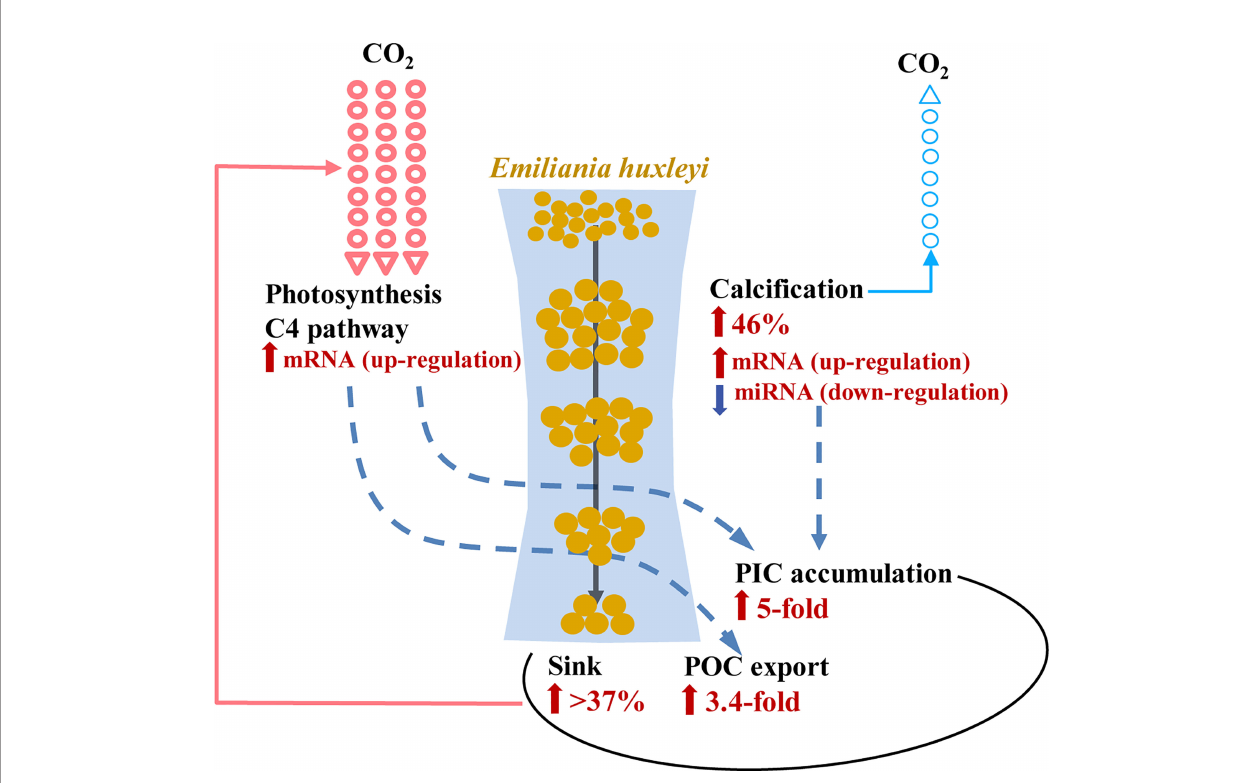
FIGURE 5 | Schematic of the enhanced ef fi ciency of E. huxleyi -mediated biological pump and the underlying molecular mechanisms under P limitation. Increases of cellular store of organic carbon (POC, by 3.4-fold) and inorganic carbon (PIC, by fi vefold) under P limitation were due to continued (despite reduced) photosynthesis underlying the up-regulation of mRNA involved in C4 photosynthesis. Enhanced calci fi cation (by 46%) was regulated by the corresponding up-regulation of mRNA and down-regulation of miRNA. Increased cell ballasting was due to depressed cell division and increased sinking rate (> 37%). The resulting increase in cellular carbon export outweighs the increase of CO 2 release due to calci fi cation